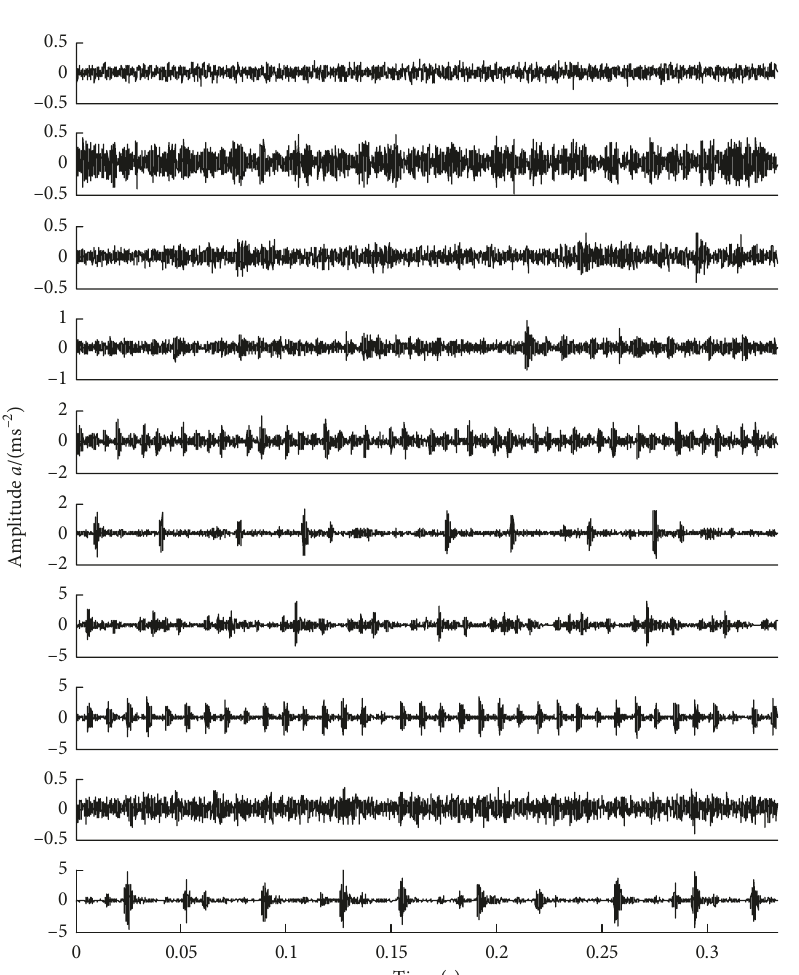
Figure 12: Vibration signals of each class. From top to bottom, the class labels of the vibration signals are 1, 2, 3, 4, 5, 6, 7, 8, 9, and 10,